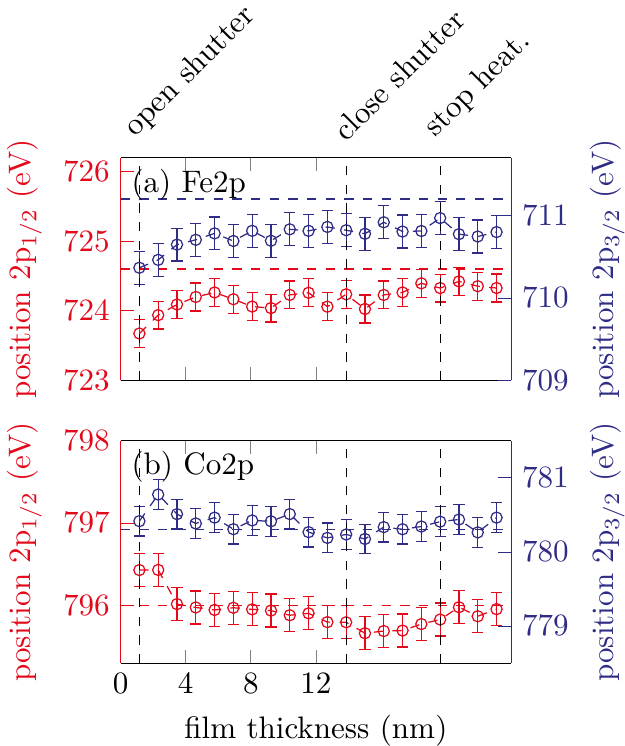
Figure 7. Peak positions of the ( a ) Fe 2p and ( b ) Co 2p peaks for sample C. The horizontal dashed lines represent the respective literature values for